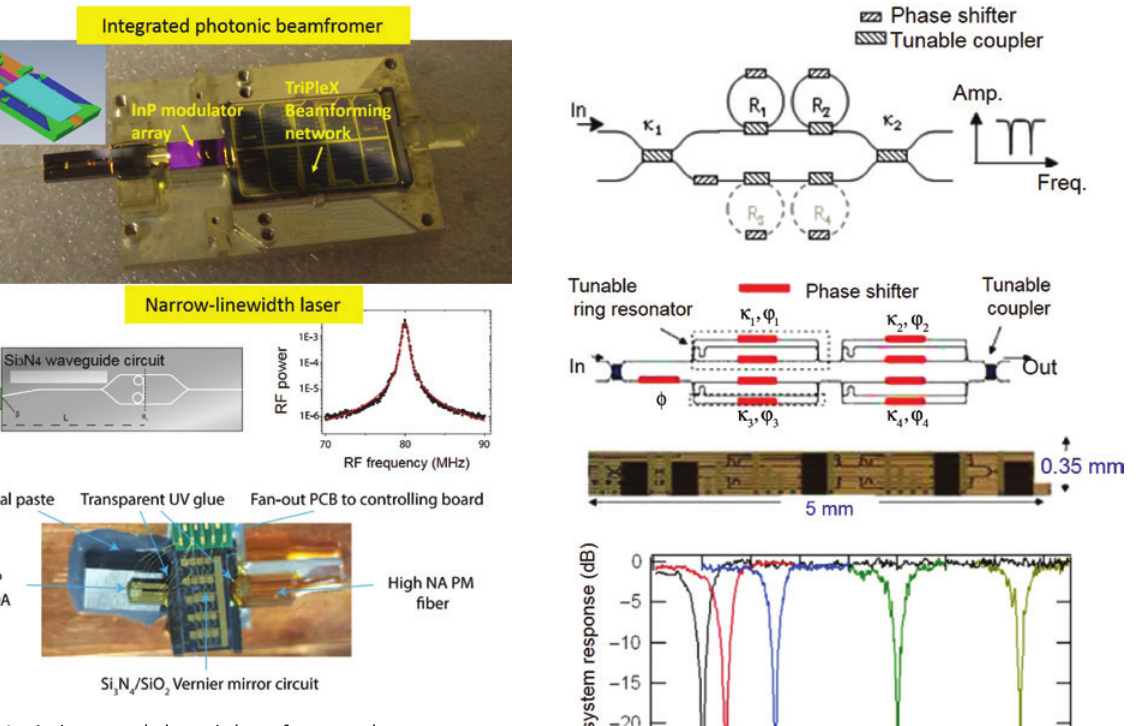
Figure 20: An integrated photonic beamformer and a narrow- linewidth laser based on a micro-assembly with InP-TriPleX hybrid integration [32, 97] (Copyright in 2015, Optical Society of America, Copyright in 2014, IEEE).